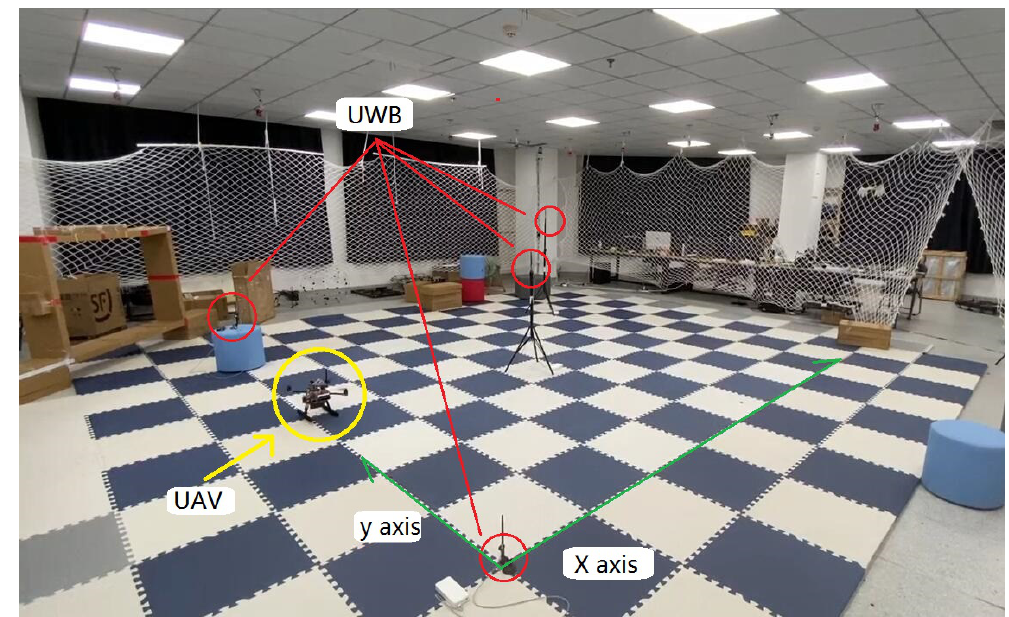
Figure 8. Experiment scene.